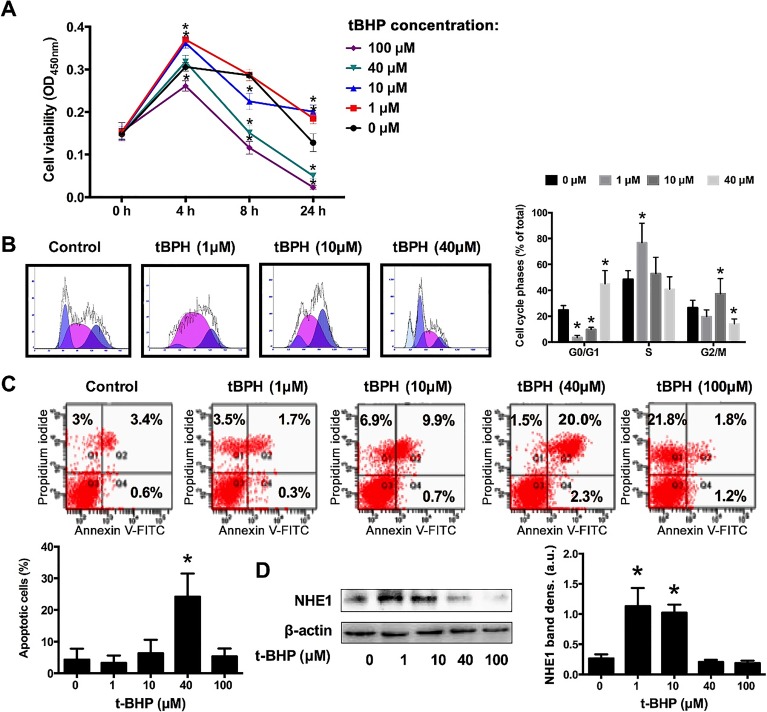
ROS induces proliferation in U2OS cells and activates NHE1 dose-dependently. Cell viability (A), cell cycle (B), apoptosis (C), and NHE1 protein expression (D) were analyzed after incubation with increasing concentrations of the ROS precursor tBHP. In the flow cytograms of (C), a cell population in the upper right corner (PI- and annexin V-positive) is characteristic of late apoptotic cells, whereas a cell population in the lower right corner (PI-negative and annexin V-positive) typifies early apoptotic cells. The quantification was performed on right upper and lower quadrant cells. Data represent mean ± SD of N = 5. *P < 0.05 compared to control.